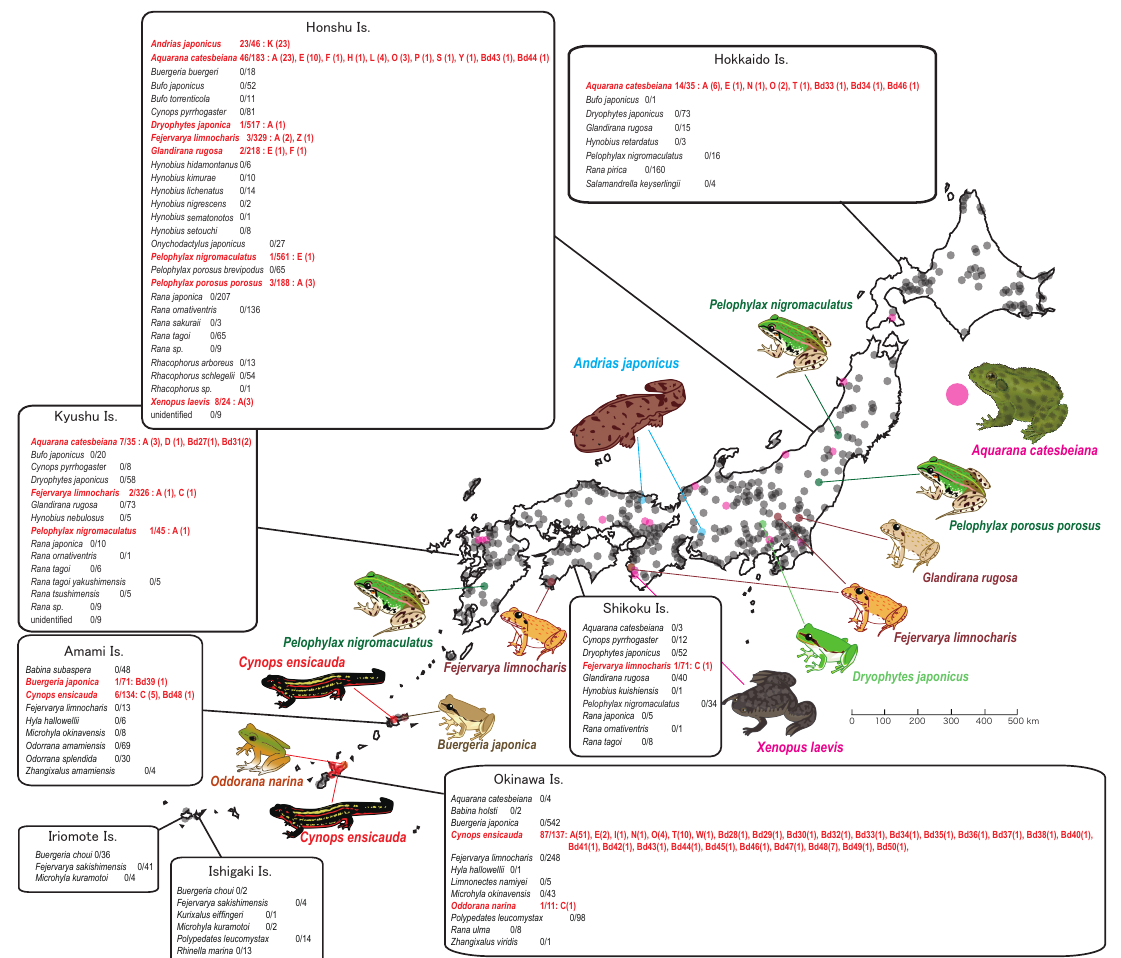
Figure 1. Distribution of Batrachochytrium dendrobatidis in amphibians across Japan. The incidence of infection in each amphibian species is defined as the number of infected animals/the number of sampled animals; the haplotype code is listed after each species. The number in parentheses represents the number of animals carrying the haplotype of interest. The circles on the map show the sampling points of swabs. Each colored circle indicates the sampling points of each amphibian species that were found to be